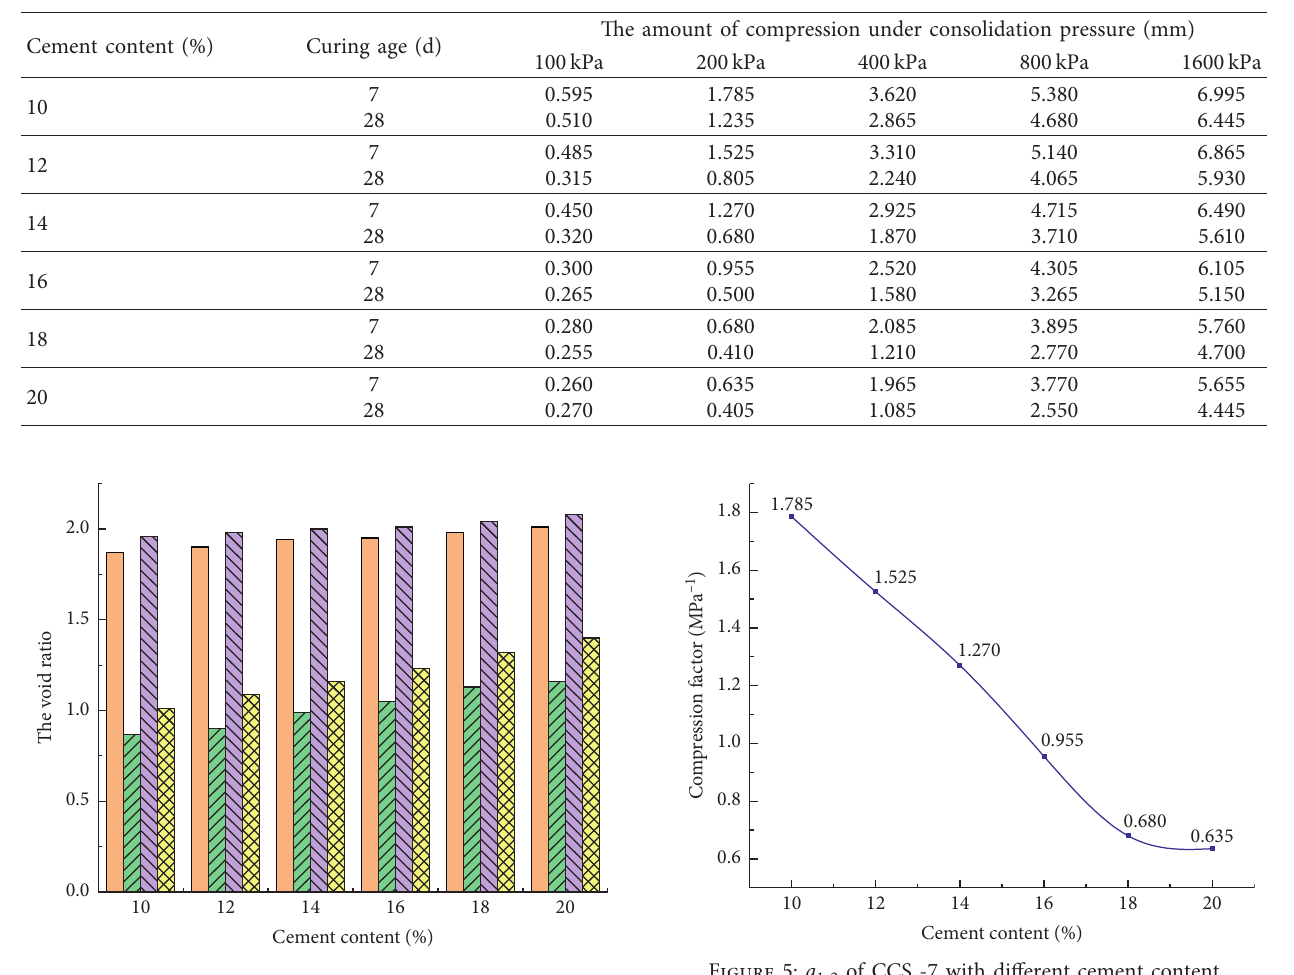
Table 6: Compression of CCS at different consolidation pressures.